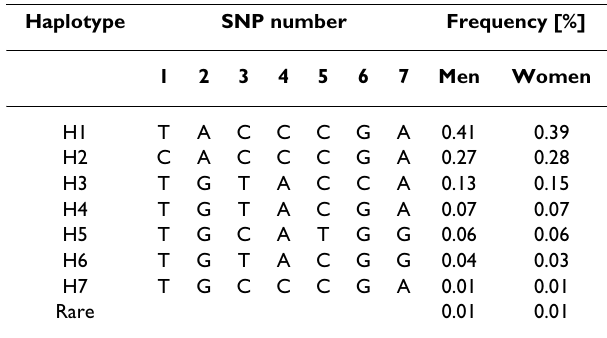
Table 3: Description of TLR4 haplotypes in the randomly drawn subcohort (n = 1,968).